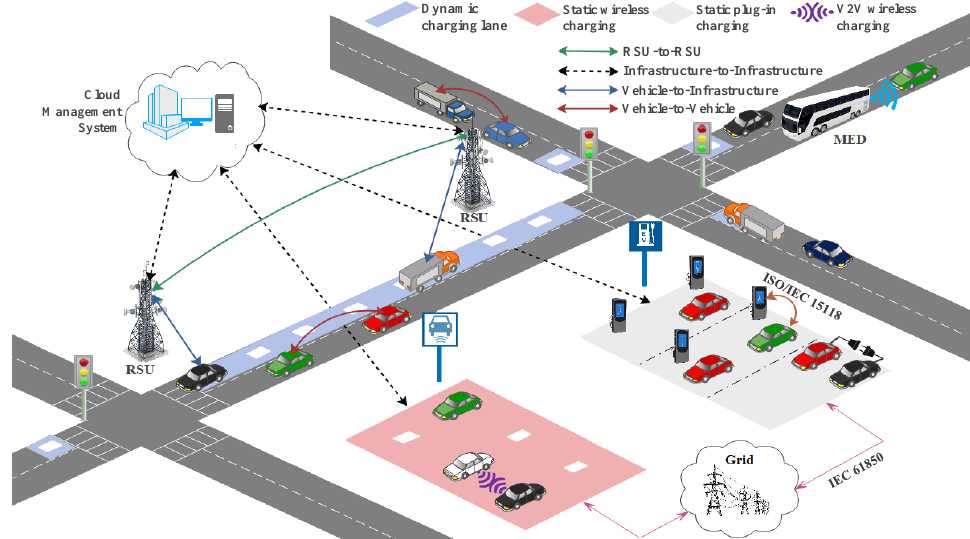
Figure 1. Overview of EV charging solutions in an Internet of Electric Vehicles (IoEV)